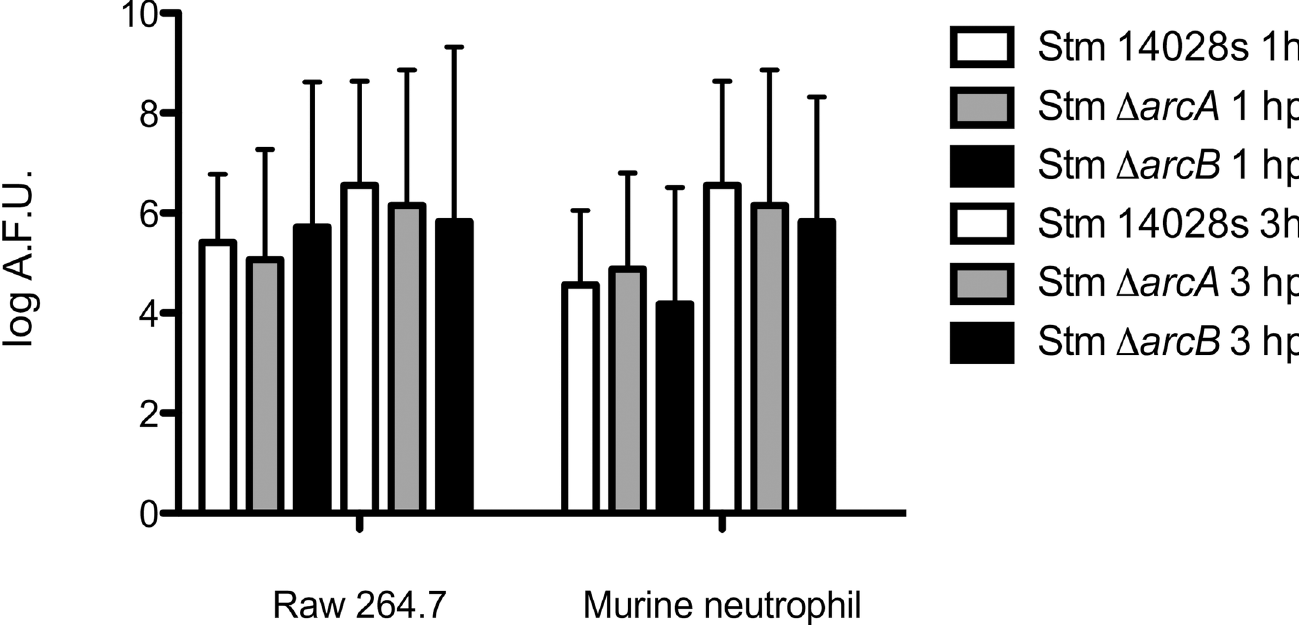
Fig 2. Total reactive oxygen species production. S . Typhimurium strains were incubated at a MOI of 100 with each cell type and ROS were evaluated at 1 and 3 hpi. The amount of ROS was determined by quantifying DCF fluorescence in neutrophils and macrophages co-cultured with the parental S . Typhimurium 14028s, and the Δ arcA and Δ arcB mutants. Values indicate Arbitrary Fluoresce Units (AFU) normalized by the number of bacteria recovered. One-way ANOVA followed by Bonferroni post hoc test.; no significant differences found at α = 0.05. Biological replicates n = 5, three technical replicates per experiment.